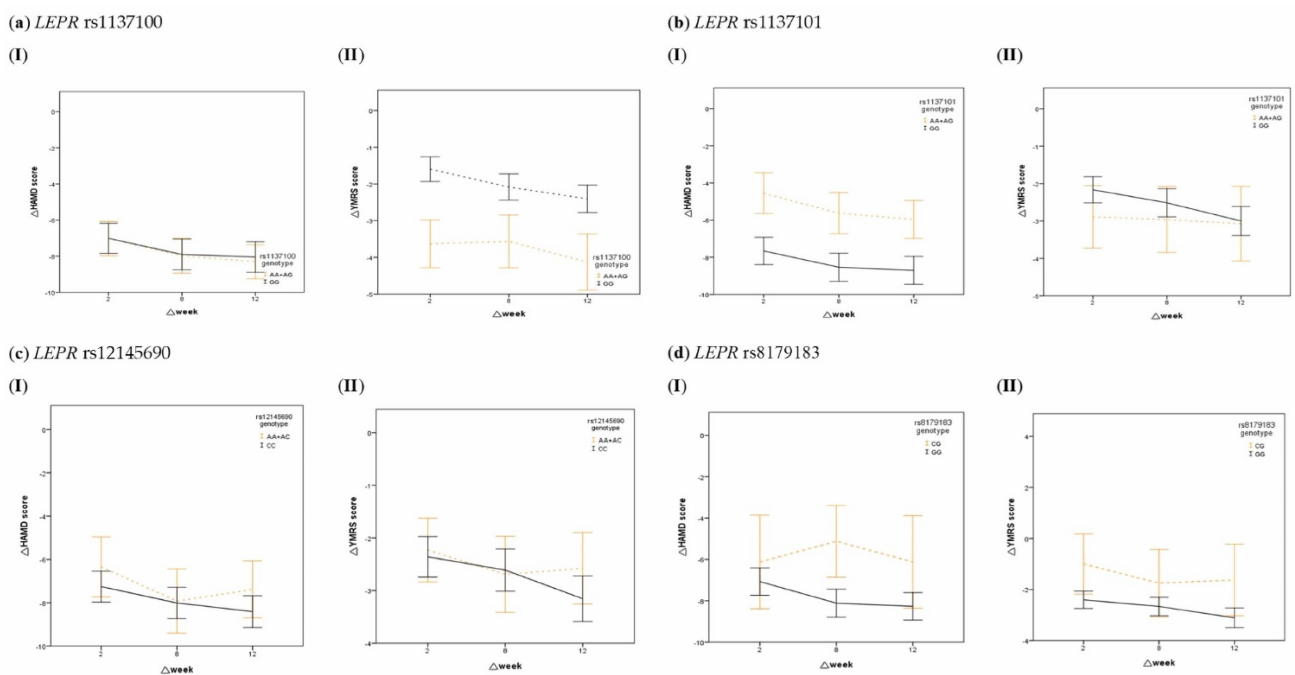
Figure 1. Effects of LEPR polymorphisms on changes in disease severity in BD patients during the 12-week VPA treatment course. Plots show the effect of LEPR polymorphisms ( a ) LEPR rs1137100, ( b ) LEPR rs1137101, and ( c ) LEPR rs12145690 and LEPR rs8179183 on the changes in disease severity ( I ) ∆ HDRS scores and ( II ) ∆ YMRS scores. ( a ) ( I ) The change in HAMD scores significantly decreased over time ( p = 0.004), but no effects of rs1137100 on the HAMD scores were found. ( a ) ( II ) The change in YMRS scores decreased significantly over time ( p = 0.011), and allele carriers of LEPR